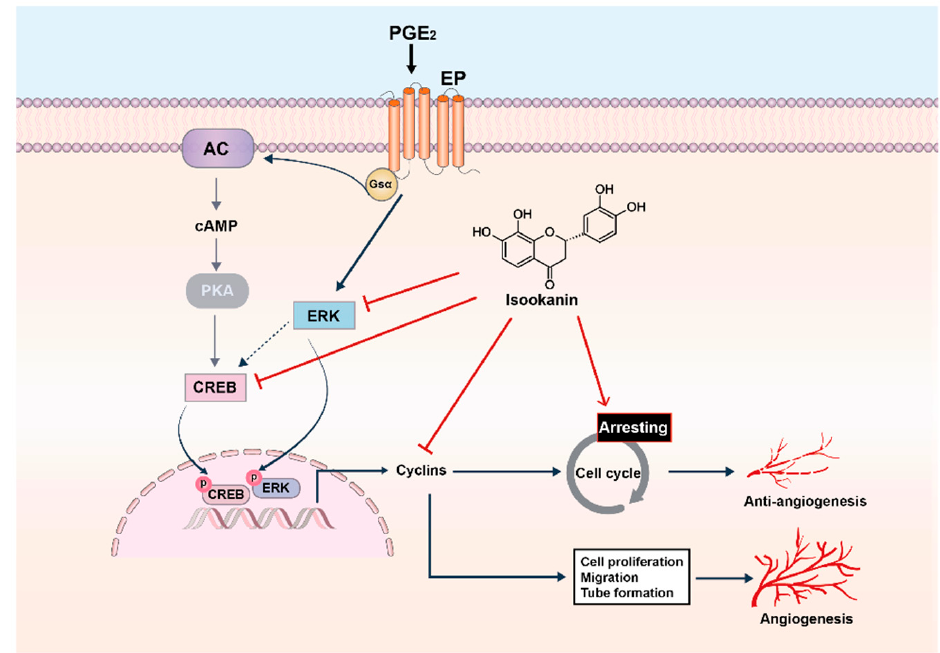
Figure 7. The mechanism of isookanin inhibiting angiogenesis is associated with suppressing PGE 2 -mediated ERK1/2 and CREB phosphorylation and with inducing cell cycle arrest. Supplementary Materials: The following are available online at www.mdpi.com/xxx/s1.